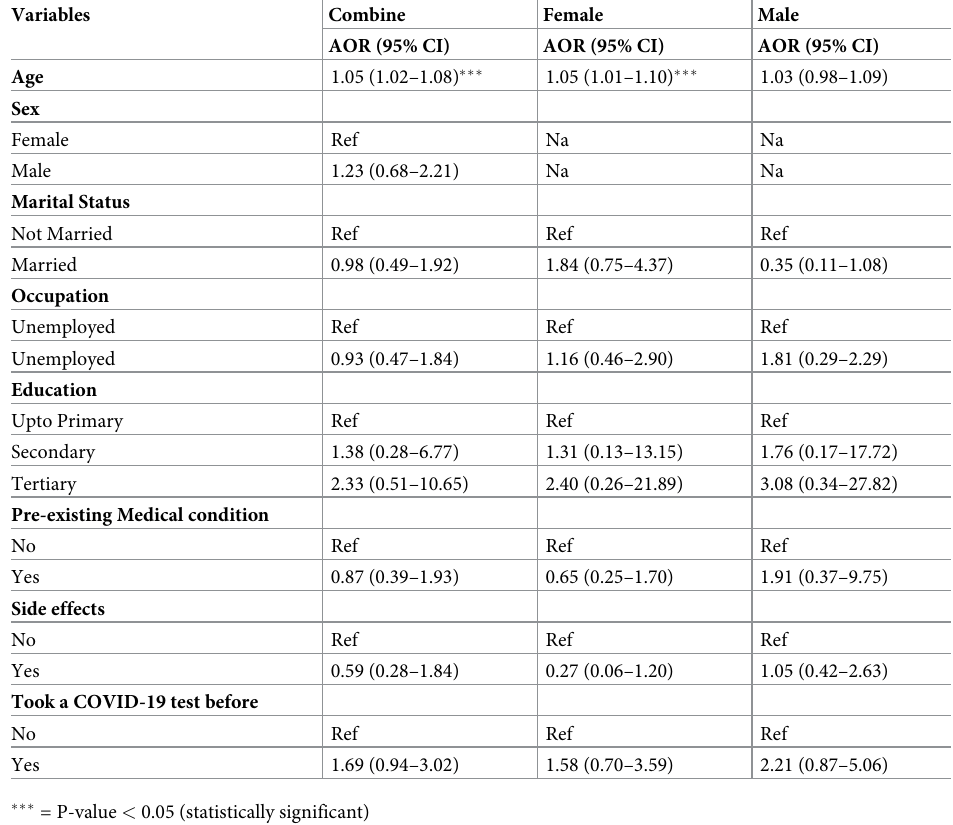
Table 3. Multivariable mixed effect logistic regression model (combined and stratified